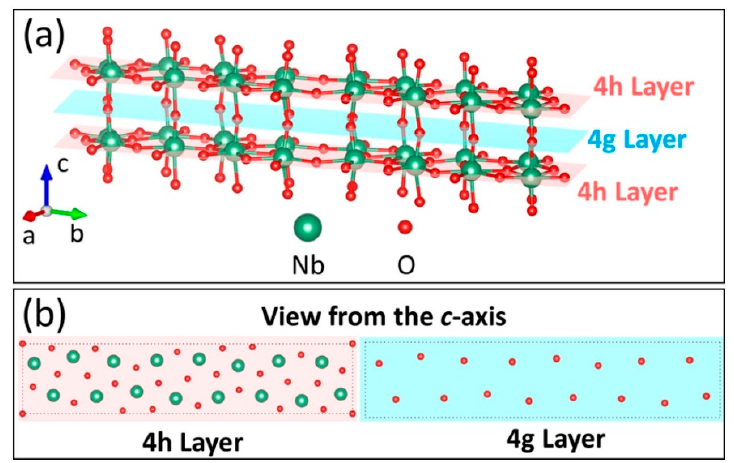
Figure 3. ( a ) Structure of T-Nb 2 O 5 with highlighted 4h layers. ( b ) Atomic arrangements of the 4h layer and the 4g layer when viewed from the c -axis view . Reprinted with permission from Ref. [48] Copyright 2017 American Chemical Society.